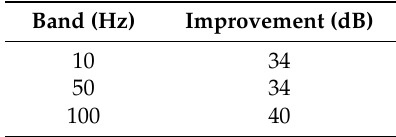
Table 1. Anti-drift improvements for different signal